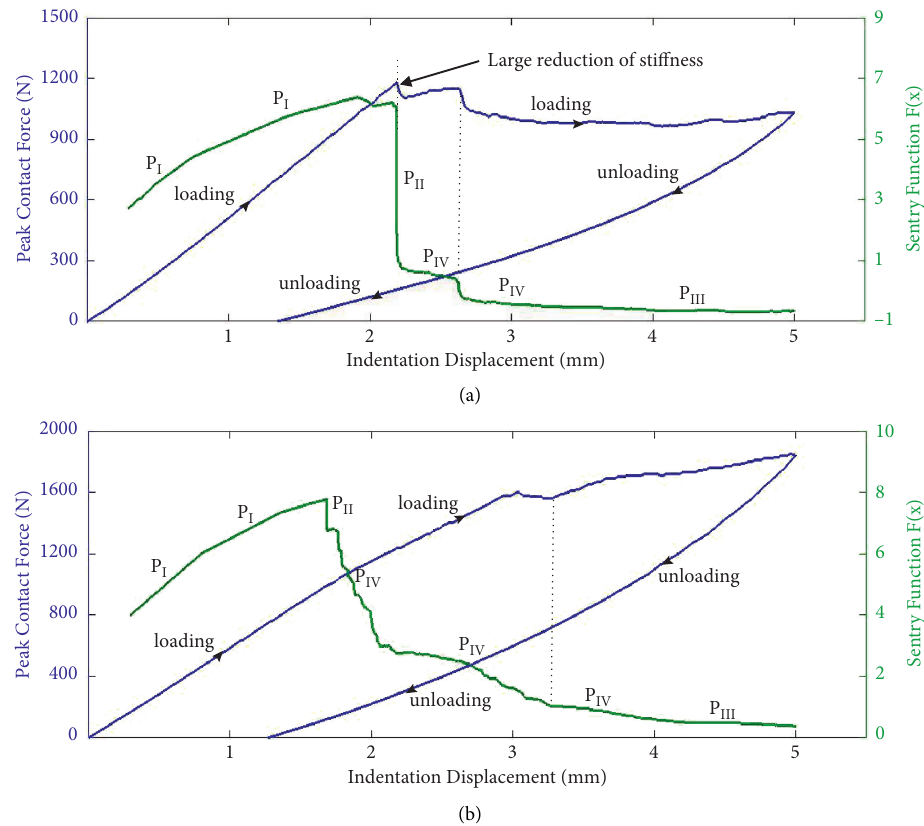
Figure 10: Load-displacement response and sentry function: (a) bidirectional glass/epoxy and (b) chopped glass/epoxy